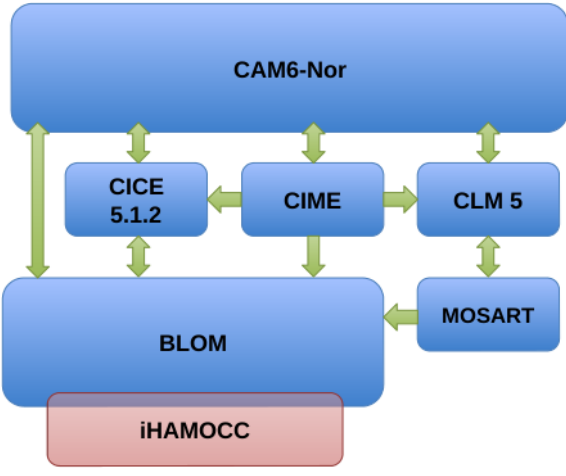
Figure 1. Overview of the different components in NorESM2 and their interactions (CIME: configuration handler; CAM6-Nor: atmo- sphere and aerosol; CICE5.1.2: sea ice; CLM5: land and vegetation, MOSART: river transport; BLOM: ocean; iHAMOCC: ocean car- bon